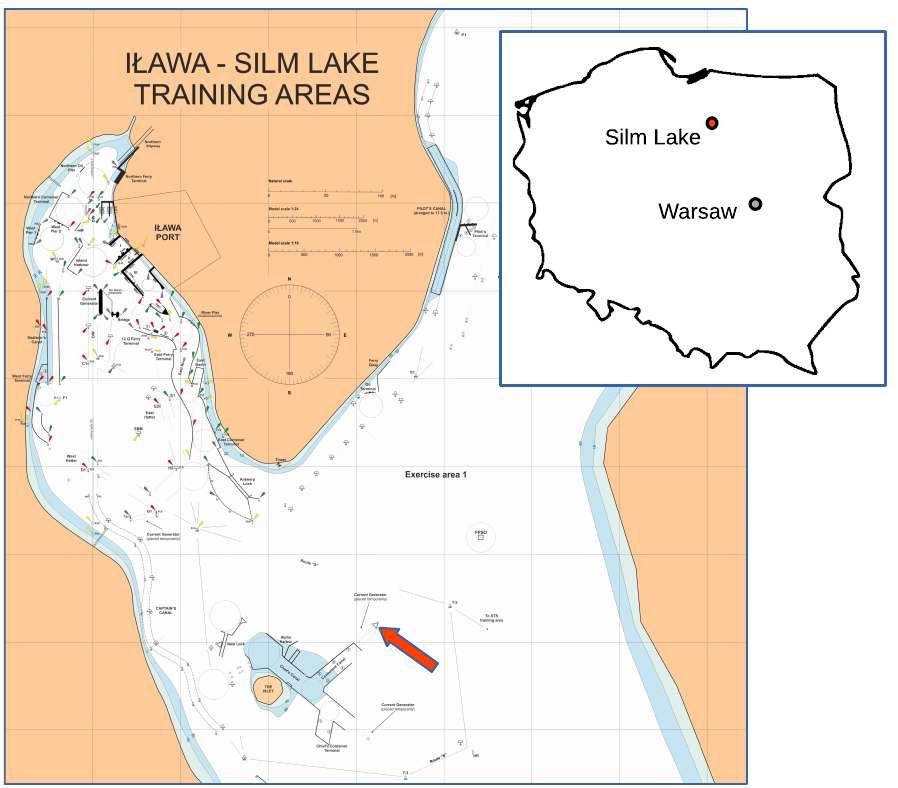
Figure 2. Silm lake map showing measurement hardware mounting place (marked with red arrow) and sketch of Poland borders with approximate location of this lake.